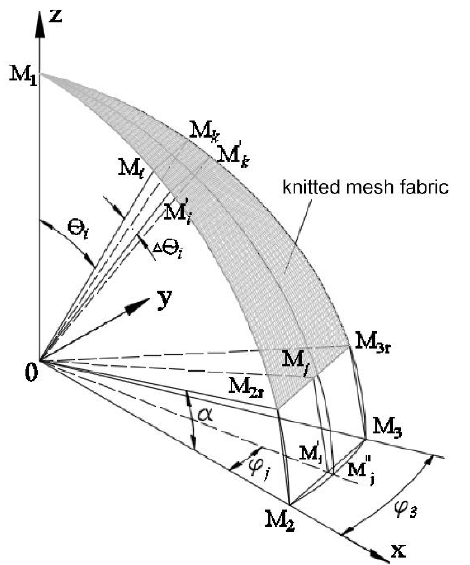
Fig. 26. Initial state of the mesh fabric of a single